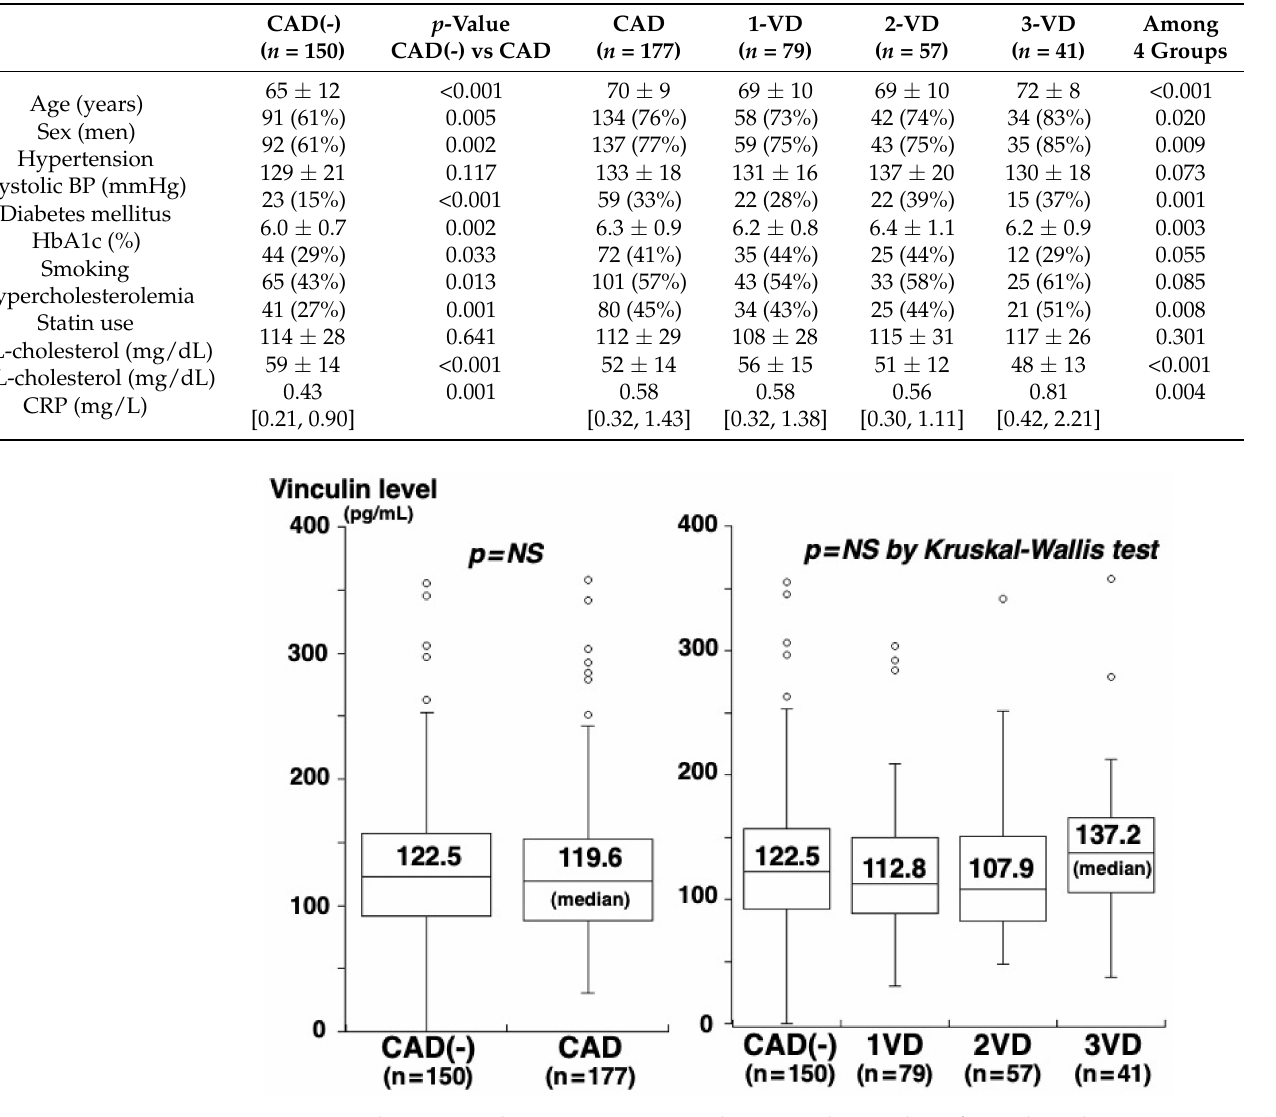
Figure 2. Plasma vinculin concentrations and CAD or the number of vessels with >50% stenosis. Vinculin concentrations were not different between the CAD(-) and CAD groups ( p = 0.325). Moreover, there was no significant difference in vinculin concentrations among the four groups of CAD(-), 1VD, 2VD, or 3VD ( p = 0.202). The central line shows the median, and the box shows the 25th to 75th